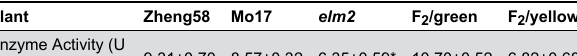
Plant Enzyme Activity